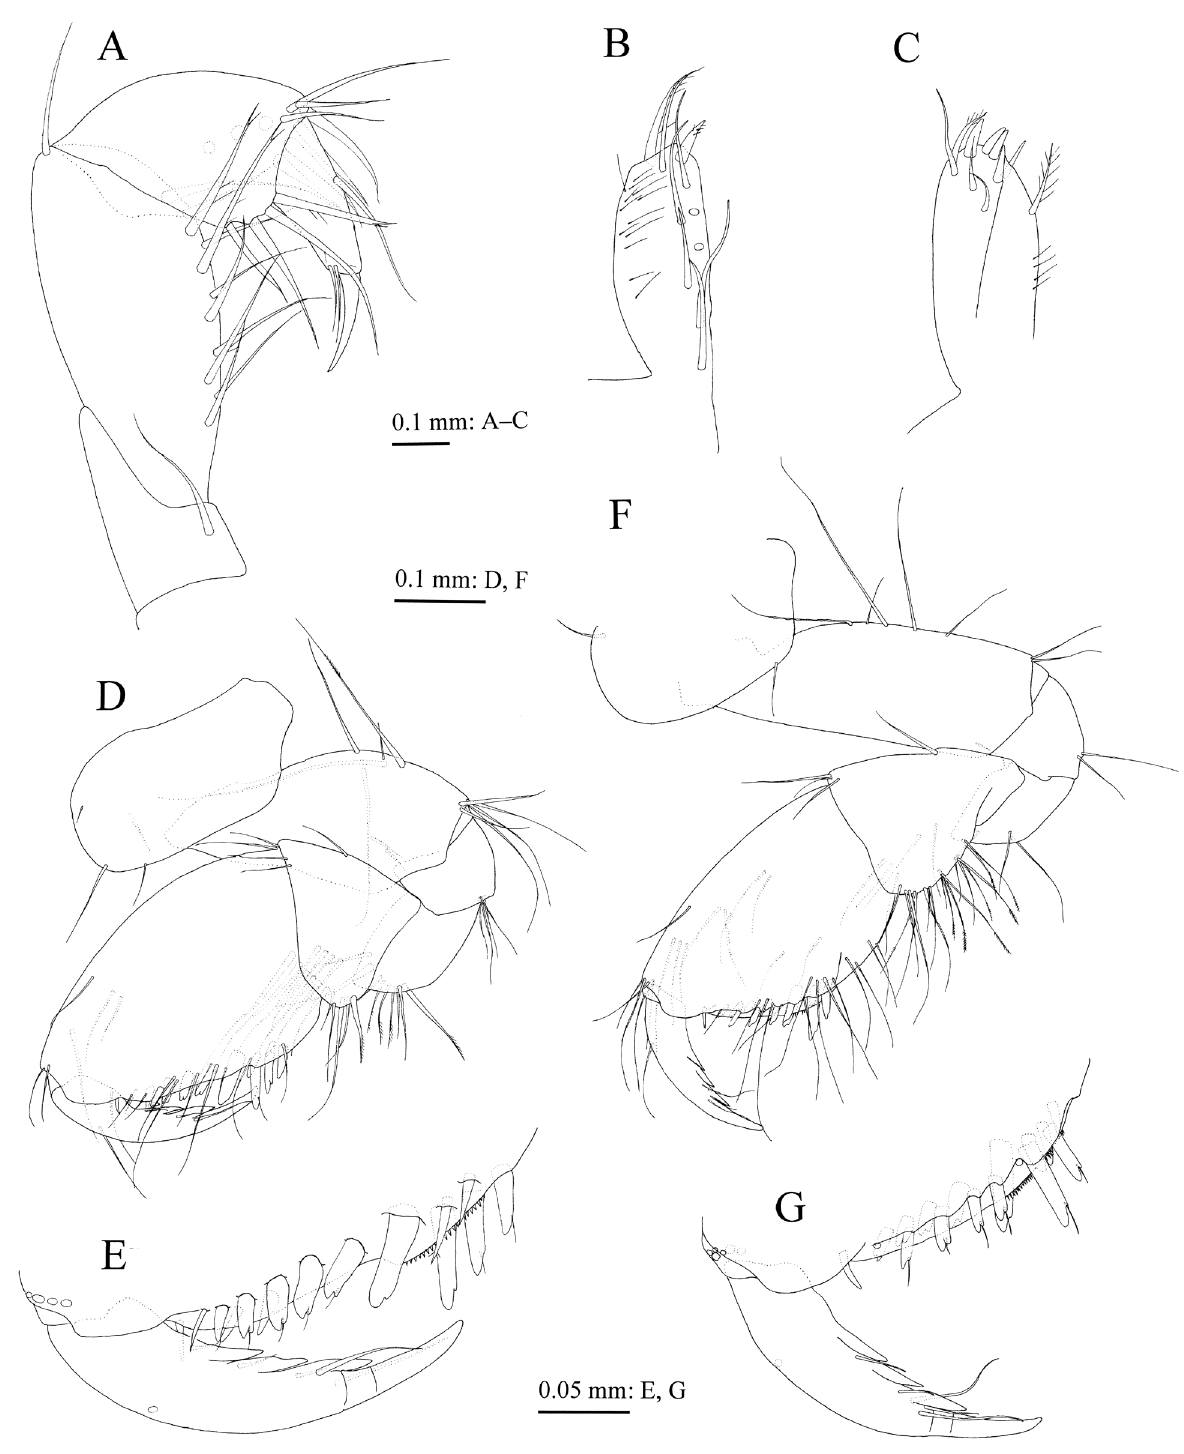
Figure 4. Pseudocrangonyx gudariensis Tomikawa & Sato, sp. n., holotype, male (3.9 mm), NSMT-Cr 24603. A maxilliped, dorsal view; B inner plate of maxilliped, dorsal view; C outer plate of maxilliped, dorsal view; D gnathopod 1, lateral view; E palmar mar- gin of propodus and dactylus of gnathopod 1, medial view; F gnathopod 2, lateral view; G palmar margin of propodus and dactylus of gnathopod 2, medial